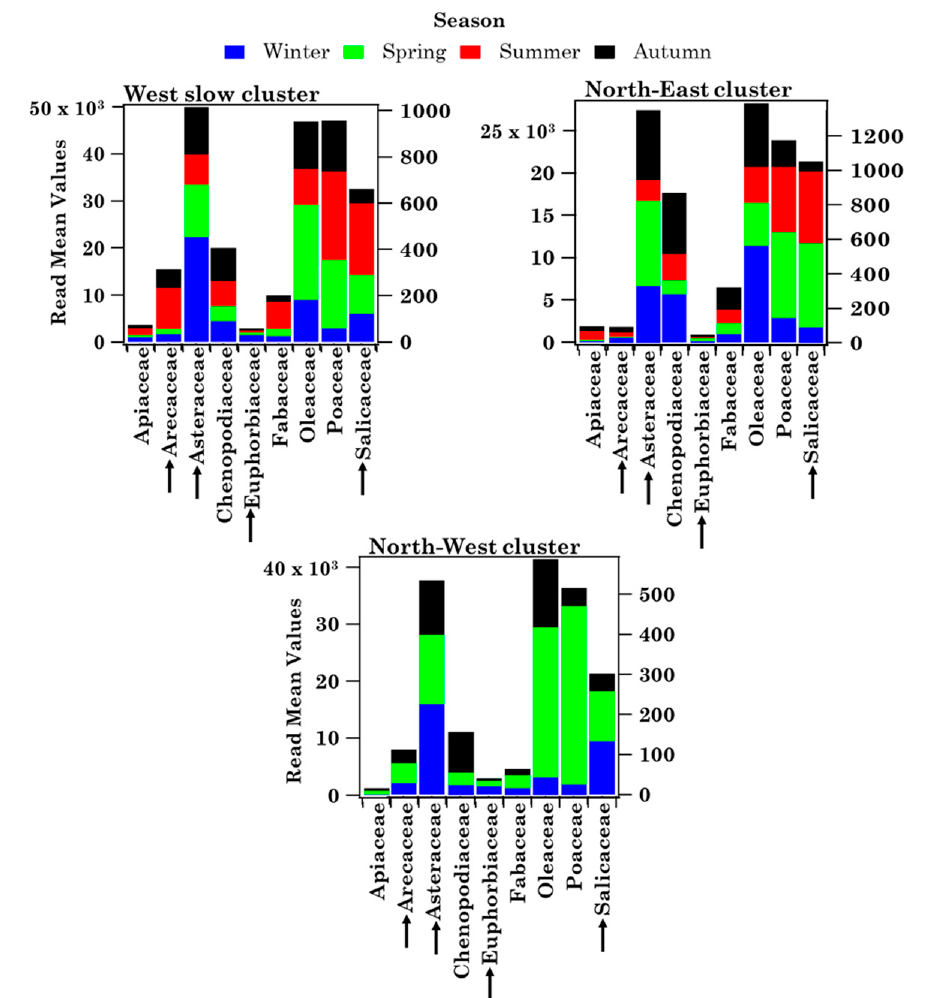
Figure 13. Read mean values (per season) of the nine families shared between Brindisi and Lecce. Each colour indicates a season, while the height of each colour bar represents the read mean value per season. The right scale refers to the families indicated by the black arrows.